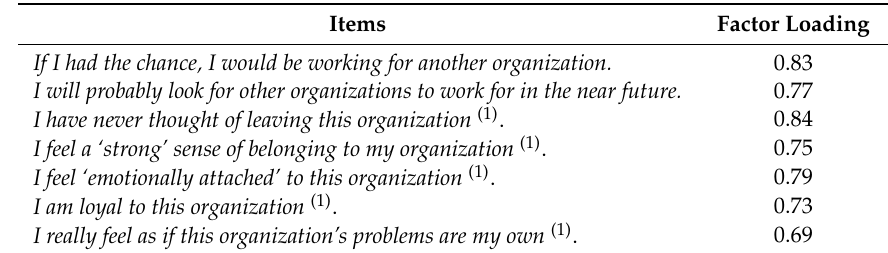
Table 7. Final items of TI scale and their standardized factor loadings.